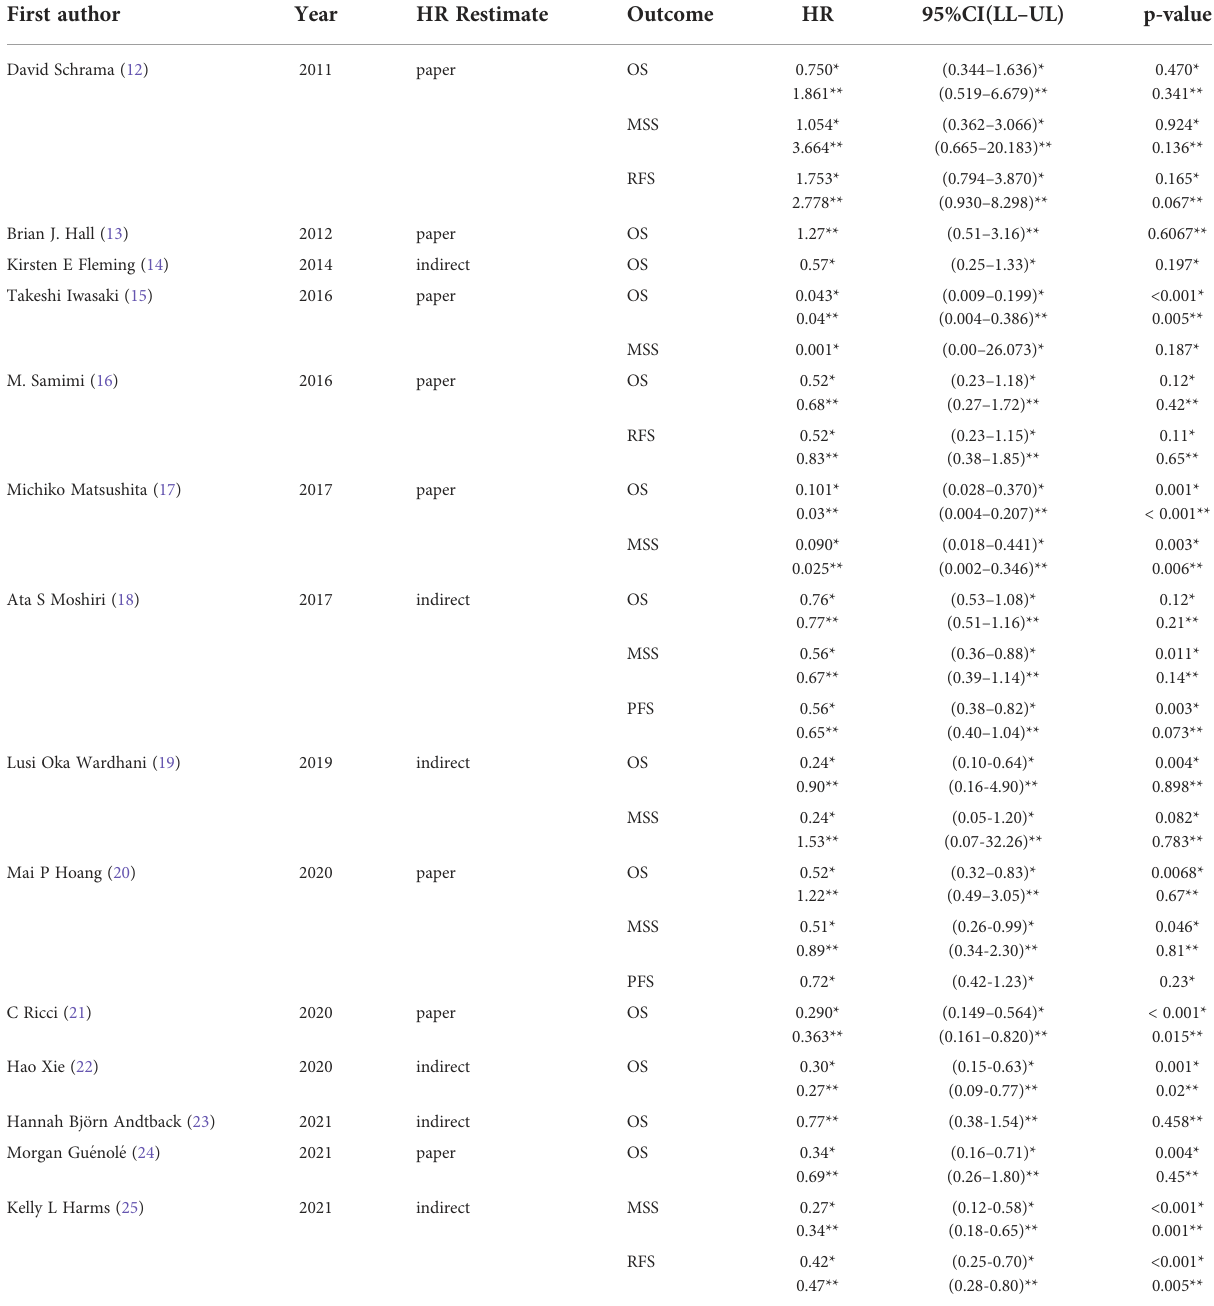
TABLE 2 HRs and their 95% CI of included